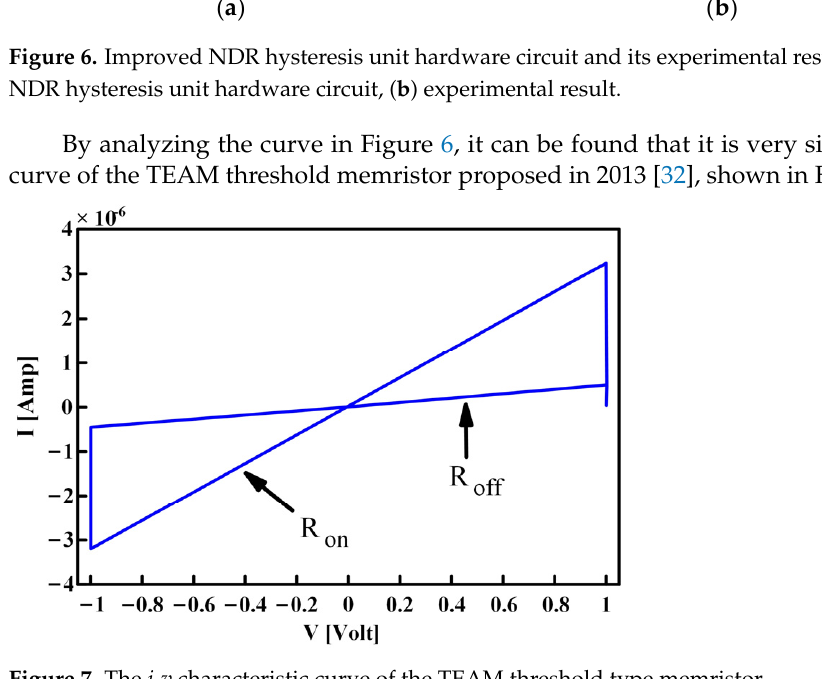
Figure 7. The i - v characteristic curve of the TEAM threshold type memristor.